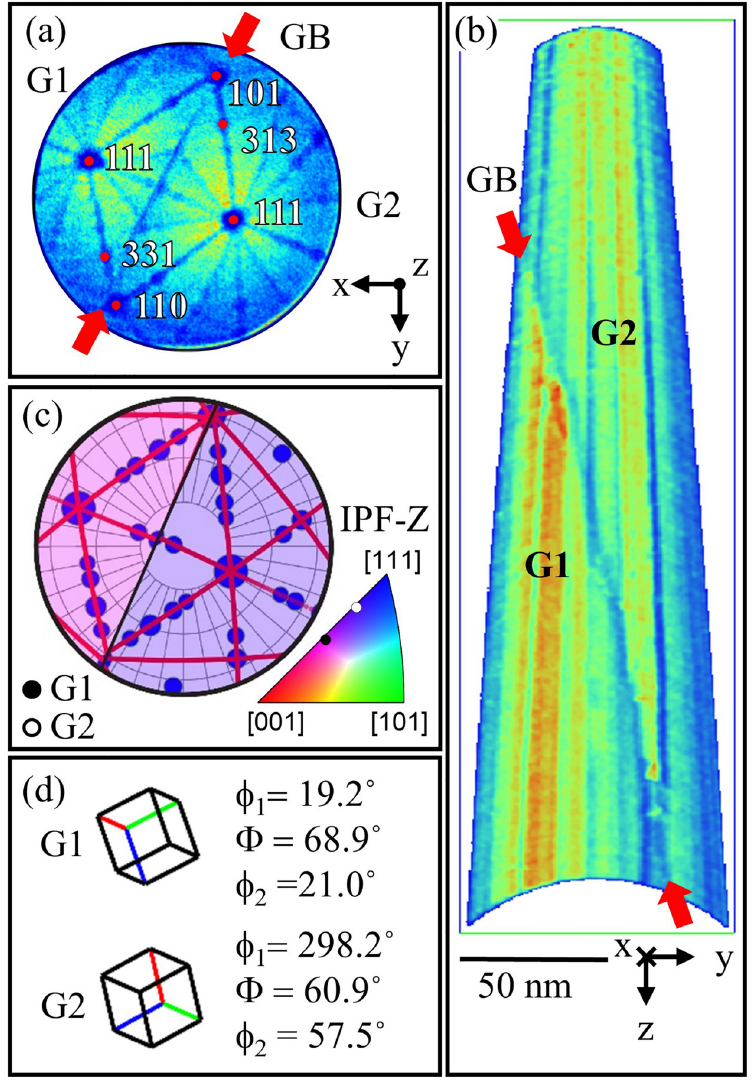
Fig 2. (a) FDM of experimental APT data of Al bi-crystal with crystallographic patterns indexed. (b) Al-density map of reconstruction, � 1.2 nm thick, through the centre of the reconstruction on the YZ-plane. (c) Stereographic projection representation of the two grains, showing low index poles and zone-lines, colored corresponding to the IPF-Z. (d) The orientation cells and Bunge-Euler notation within the APT detector frame. entire reconstruction along the x = 0 plane. The inherent crystallographic information con- tained in Fig 2(a) was then used to directly calculate the orientation of each grain relative to the APT detector. Fig 2(c) is a stereographic projection representation of each grain. Each grain is colored according to the orientation within the IPF-Z color triangle. The colors are close to those used for the TKD IPF map but are not exactly the same due to the slightly differ- ent physical orientation of the needle within the atom probe compared to the EBSD setup. Fig 2(d) are the corresponding unit cell and Bunge-Euler notation of each grain. The disorienta- tion angle/axis pair, which is independent of the specimen frame, was then calculated from the APT measurements and found to be 59.4˚/[0.624, 0.555, 0.550] and is in excellent agreement with that measured from TKD.